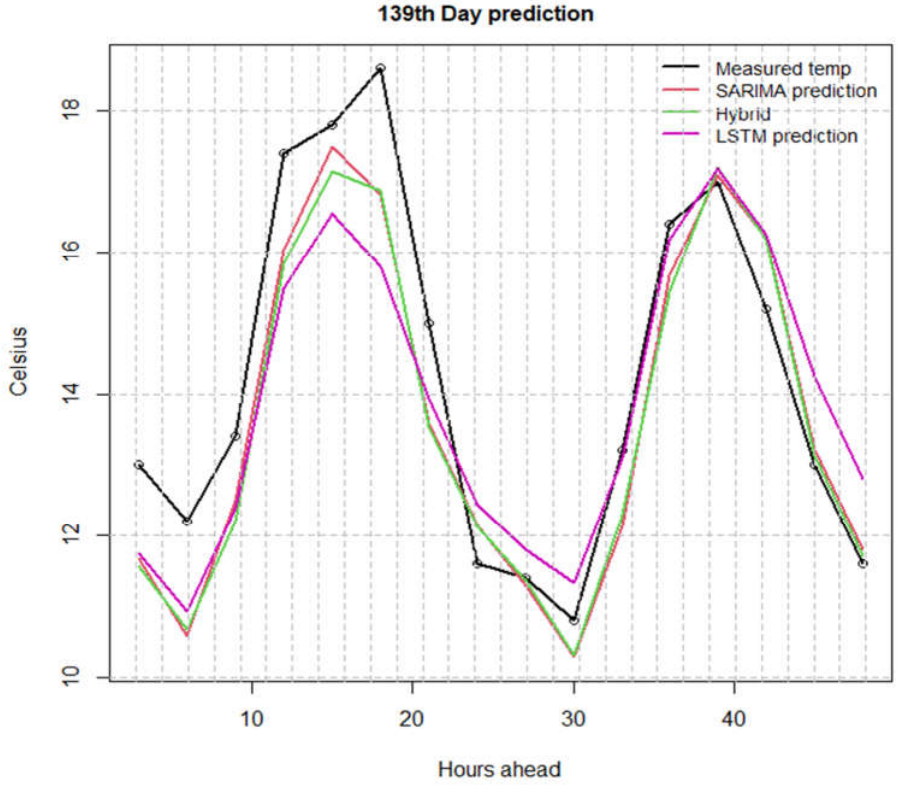
Figure 6. Comparison of SARIMA, LSTM and hybrid with real data on temperature example for 2-day prediction horizon in March; stable temperature example where hybrid is not achieving a correction on the